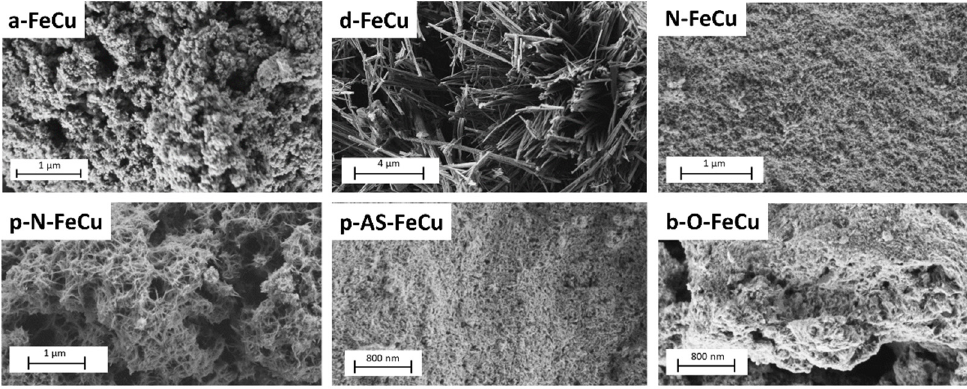
Figure 5. SEM images of the bimetal samples “a-FeCu”, “d-FeCu”, “N-FeCu”, “p-N-FeCu”,” p-AS-FeCu” and “b-O-FeCu”, exhibiting different morphologies of the prepared samples, which derive from different support structures and preparation procedures.